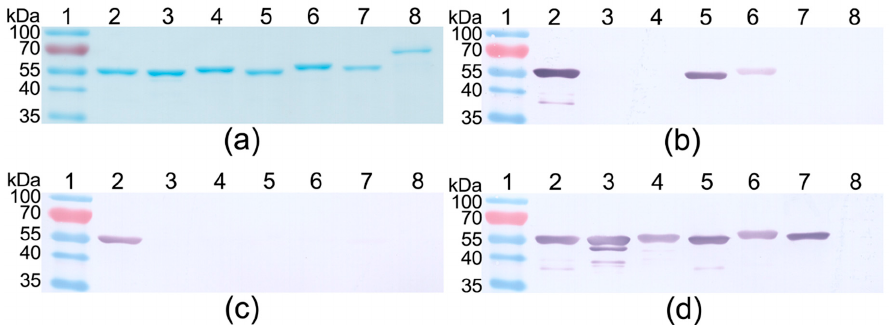
1 ELISA results are presented as dissociation constant (K d ) values (nM) obtained from ELISA titration curves. The K d is defined as the MAb concentration (nM) that gives 50% of the maximum binding with the respective antigen; 2 WB—a visible band defined as a positive reaction “+”, no band defined as a negative reaction “ − ”.